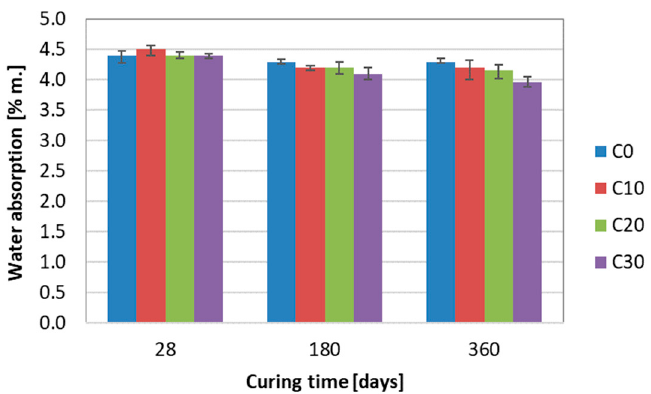
Figure 8. Water absorption of concrete as a function of basalt dust content and hardening time.